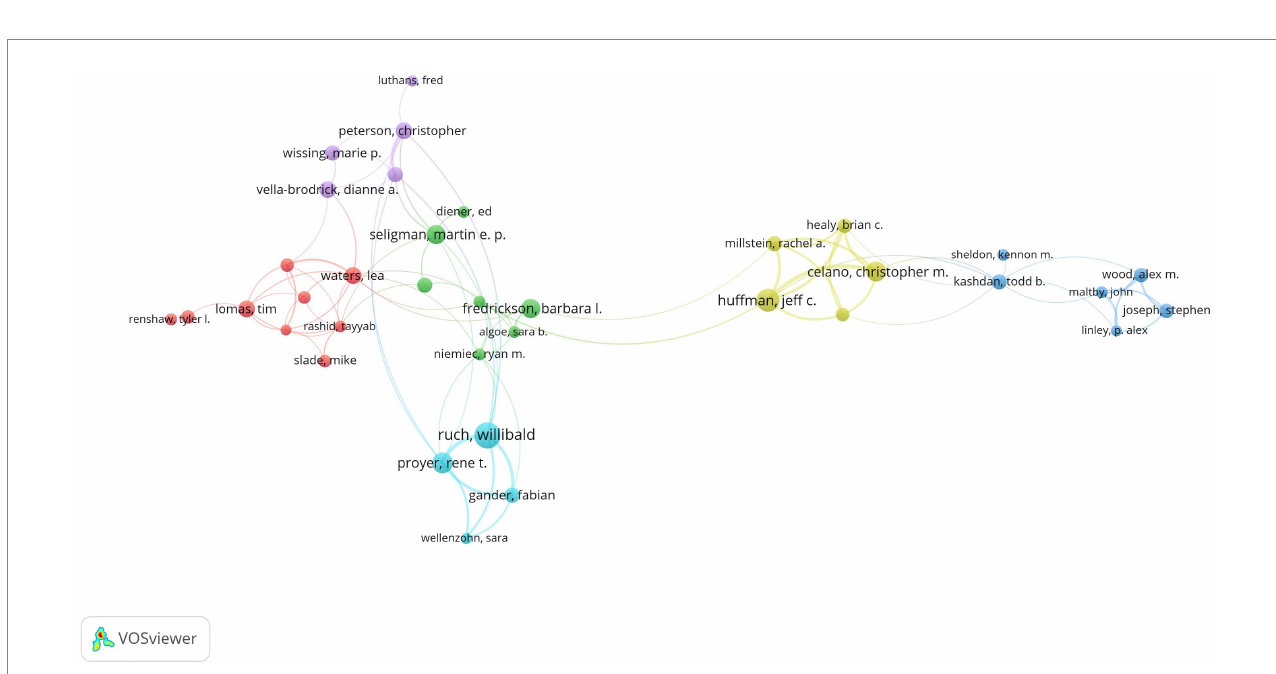
FIGURE 6 The largest author collaboration network in positive psychology